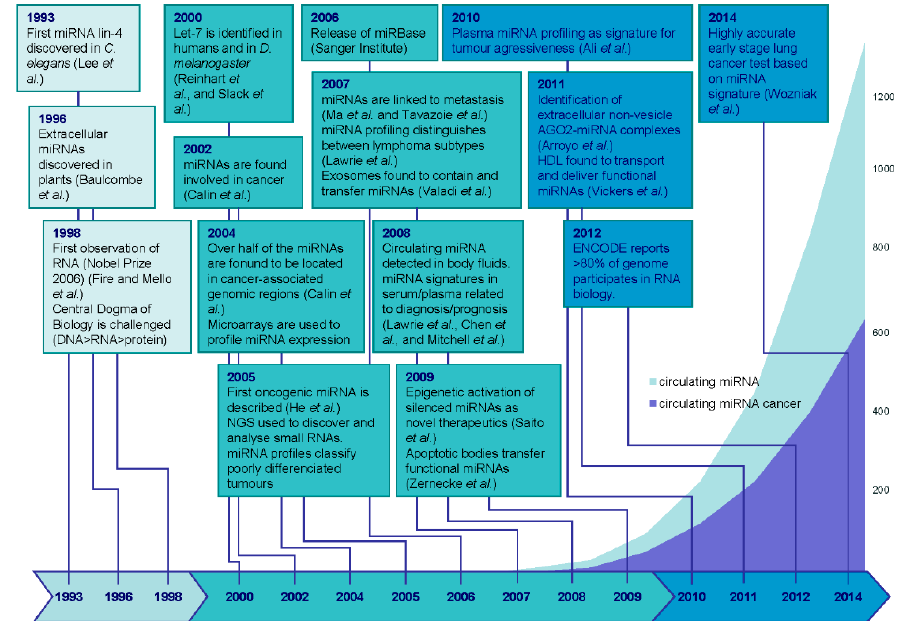
Figure 1. Chronological timeline of key discoveries in the microRNA (miRNA) field and their relevance to cancer. The overlapping plot depicts the number of PubMed-indexed publications for miRNA (dark blue) or miRNA related to cancer (light blue).